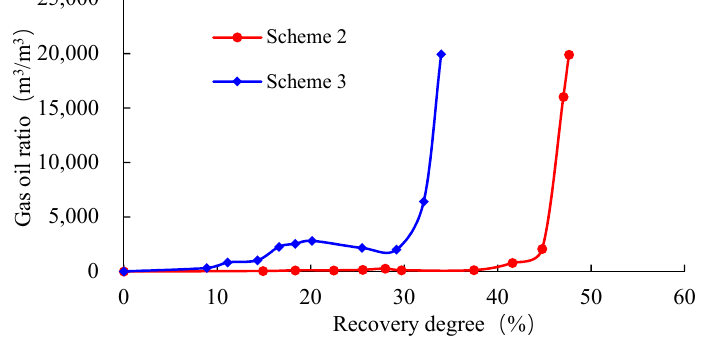
Figure 20. The relationship between recovery degree and gas–oil ratio (Scheme 2 and Scheme 3).